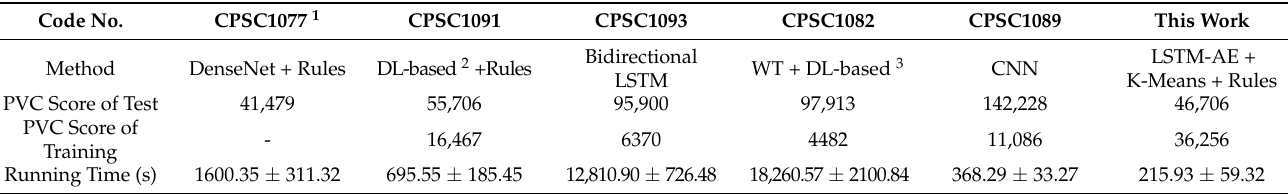
Table 3. Detailed information on three